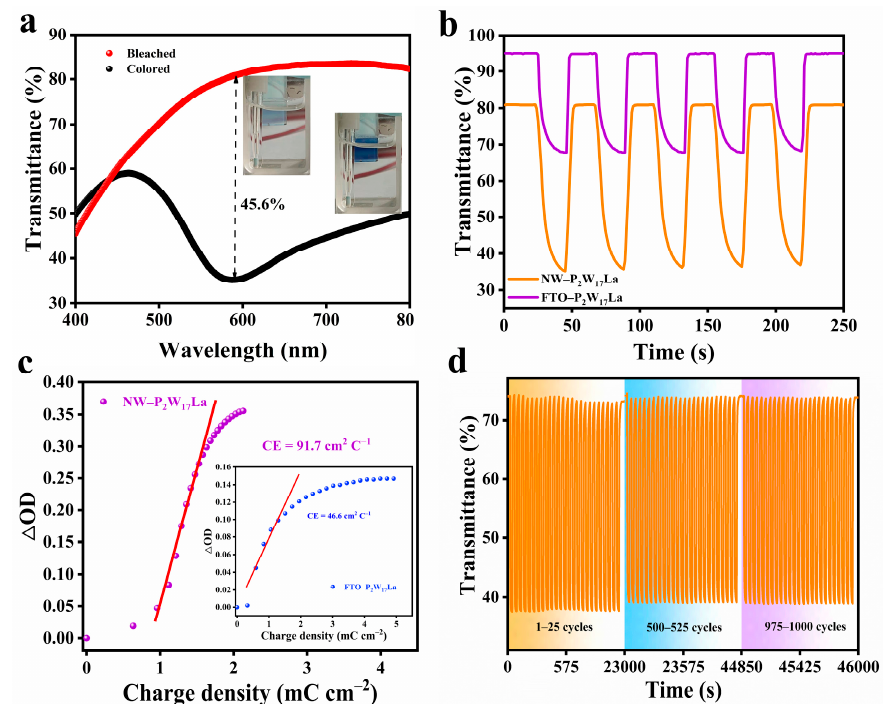
Figure 4. ( a ) Visible transmittance spectra of the NW–P 2 W 17 La composite film in the bleached and colored states at 0 V and − 1.3 V (insets: digital photographs). ( b ) In situ transmittance curves of the FTO–P 2 W 17 La and NW–P 2 W 17 La films at 591 nm during pulse voltages ( − 1 V and +1 V). ( c ) Plot of optical contrast versus charge density for NW–P 2 W 17 La and FTO–P 2 W 17 La films. ( d ) Cycle stability of NW–P 2 W 17 La film at 591 nm under pulse voltages of − 1 V and +1 V.